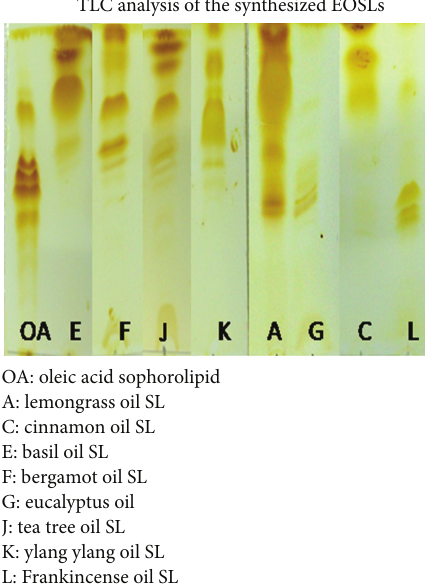
Figure 1: TLC analysis of synthesized